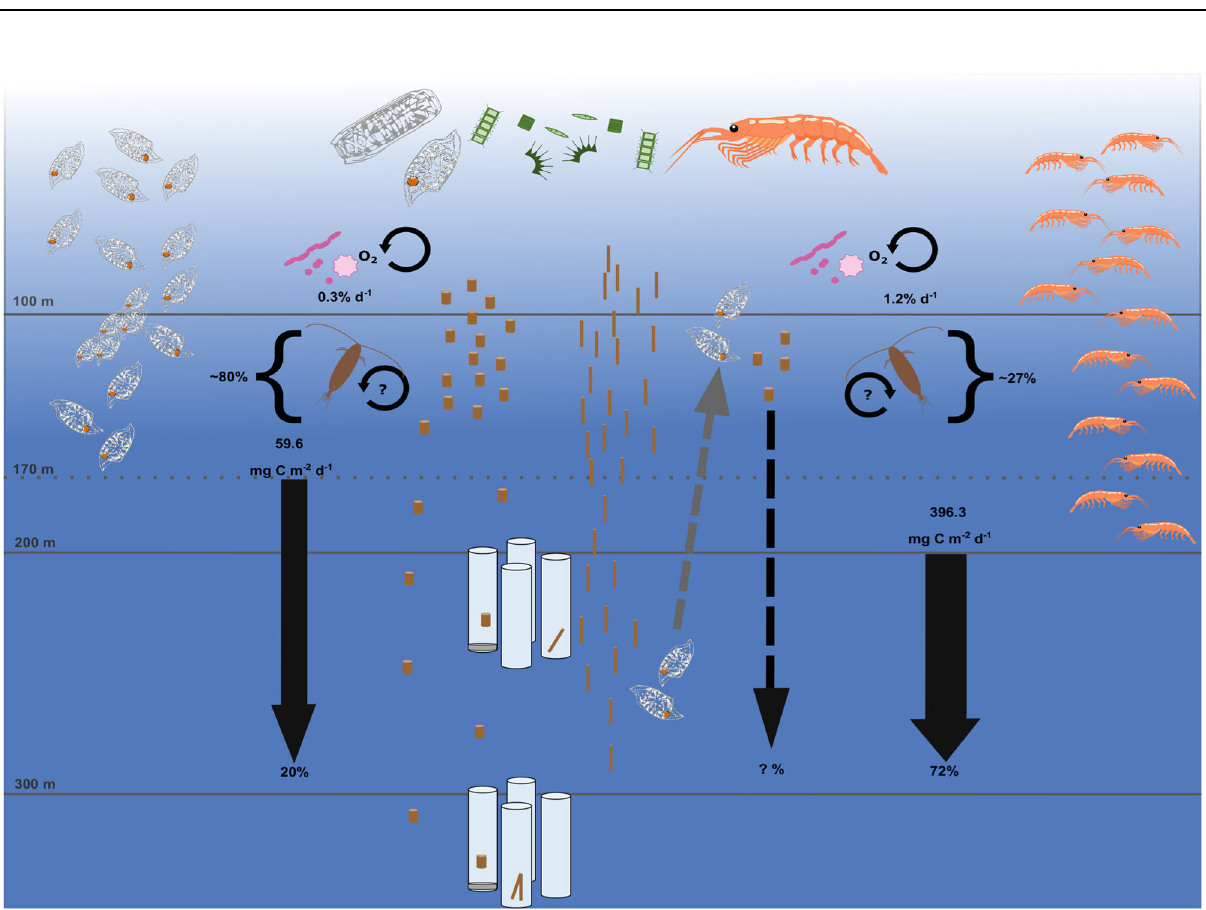
shown, respectively. In addition to the values for each DF, a mean across all traps is shown with standard deviation (SD).